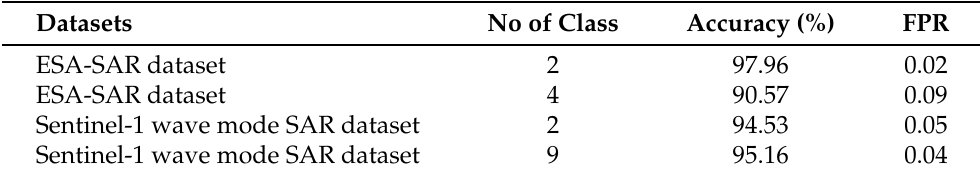
Table 1. Results for both dataset with different number of classes using first feature extraction approach (ImageNet pretrained (resnet50) features).